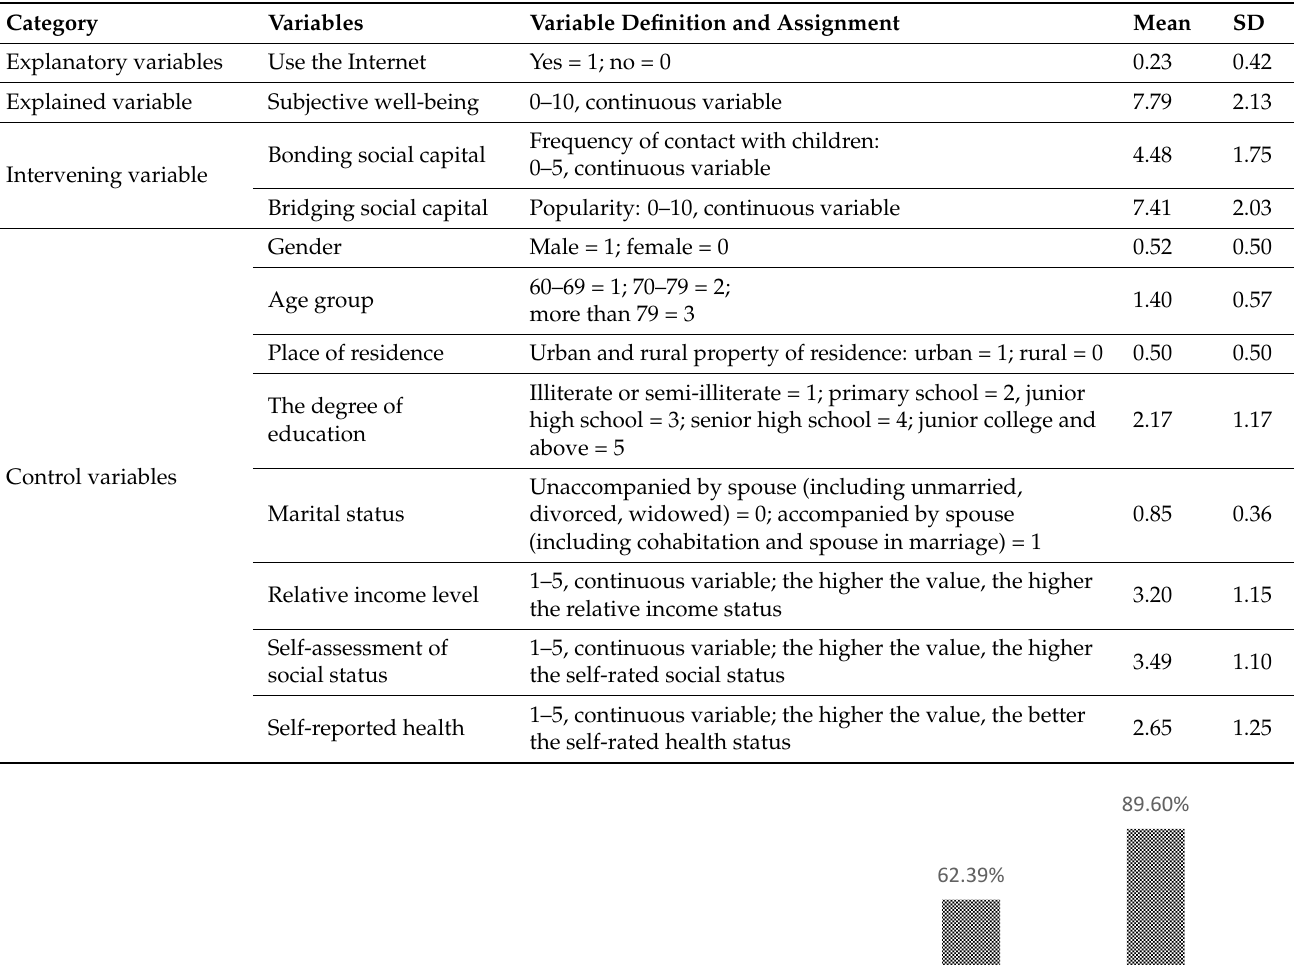
Table 1. Descriptive statistics of relevant variables.